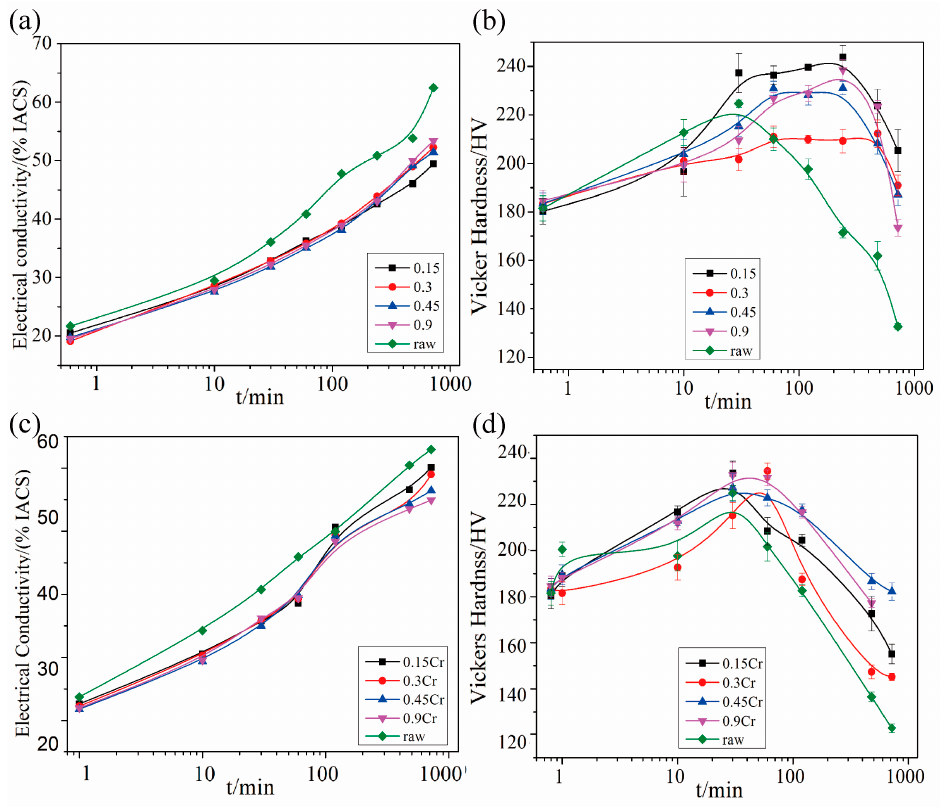
Figure 7. Isothermal aging curves of CuNiSiCr alloys aged at 698 K ( a , b ) and 723 K ( c , d ).